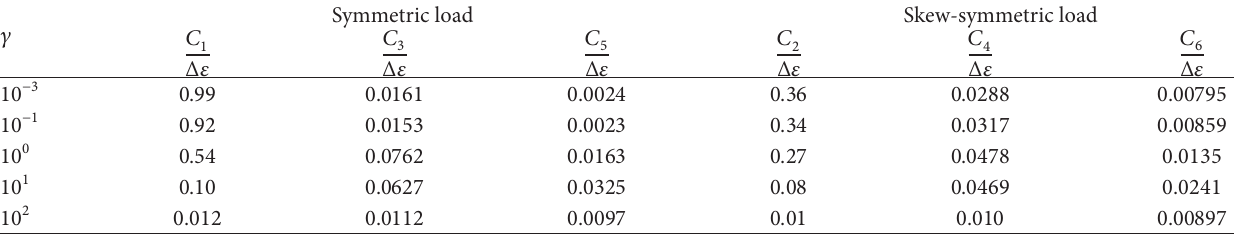
Table 3: Sensibility of 𝐶 𝑛 with respect to 𝛾